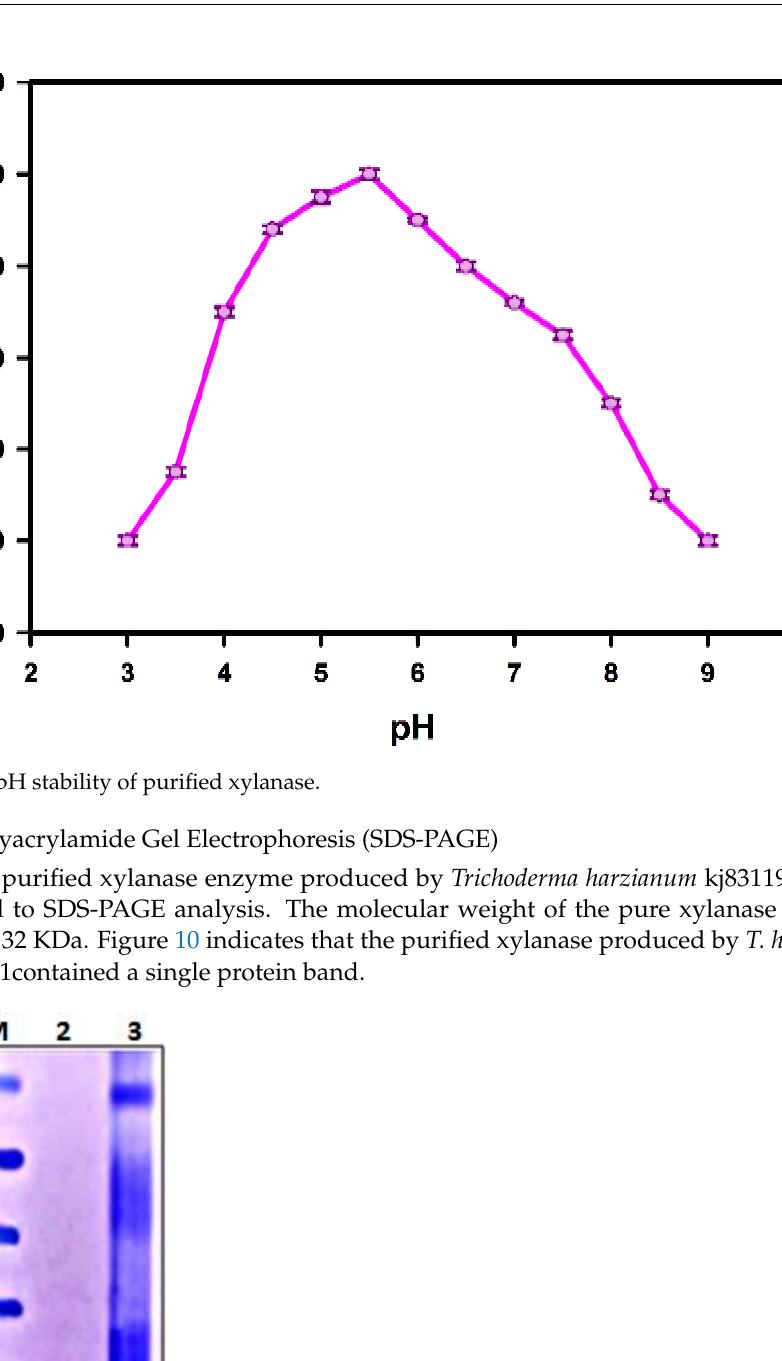
Figure 8. Temperature stability of purified xylanase.